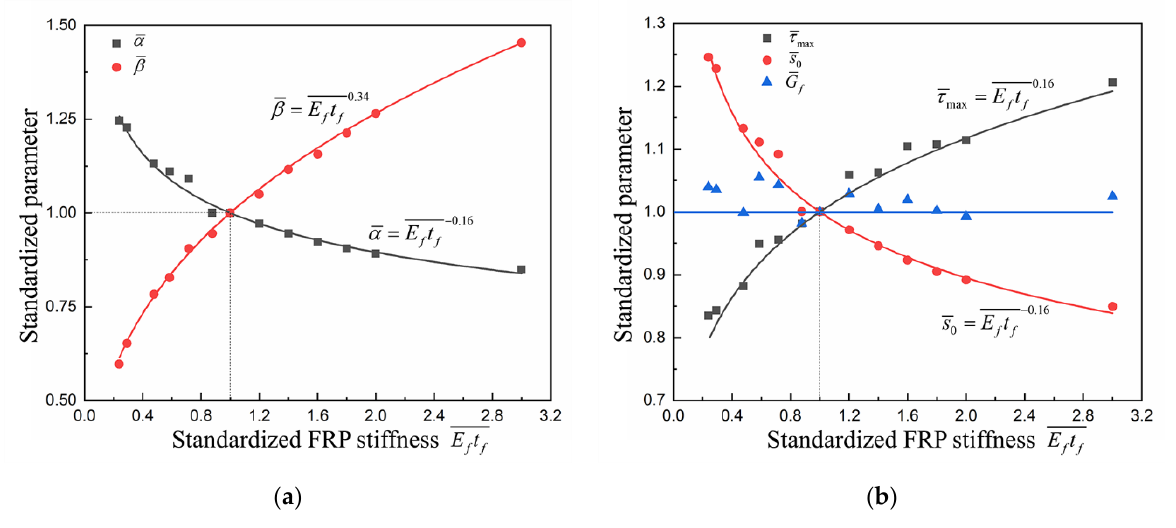
G .  , s and f max 0